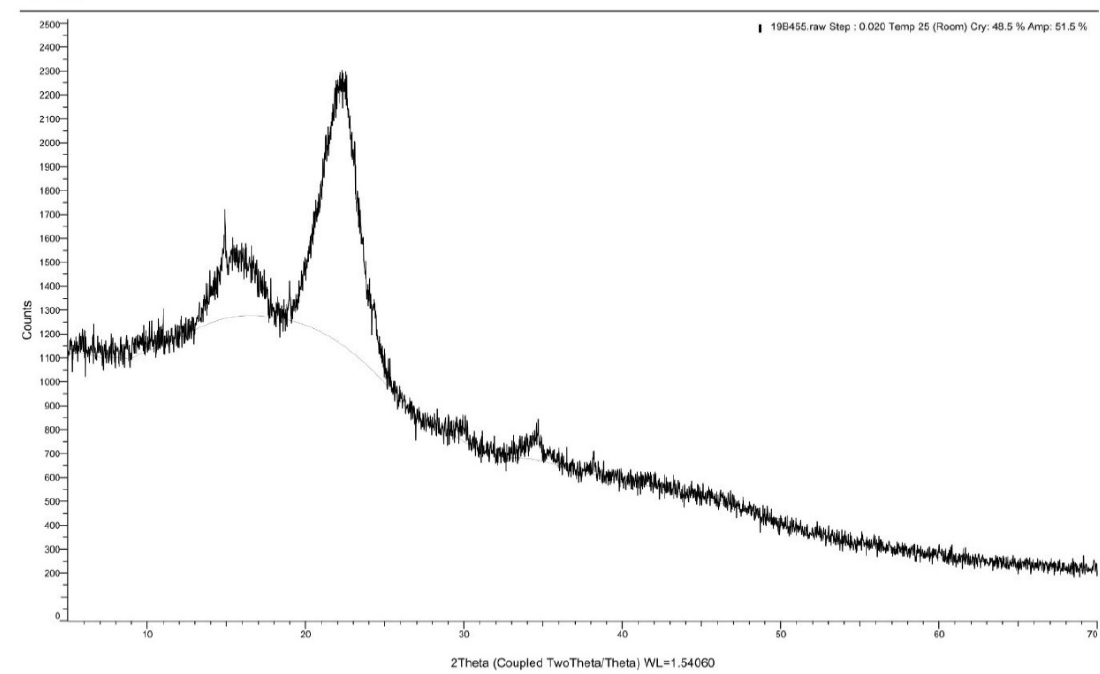
Polymers 2021 , 13 , x FOR PEER REVIEW Figure 5. X-ray diffraction spectrum for Rhizophora spp. particleboard bonded with 6% binders.